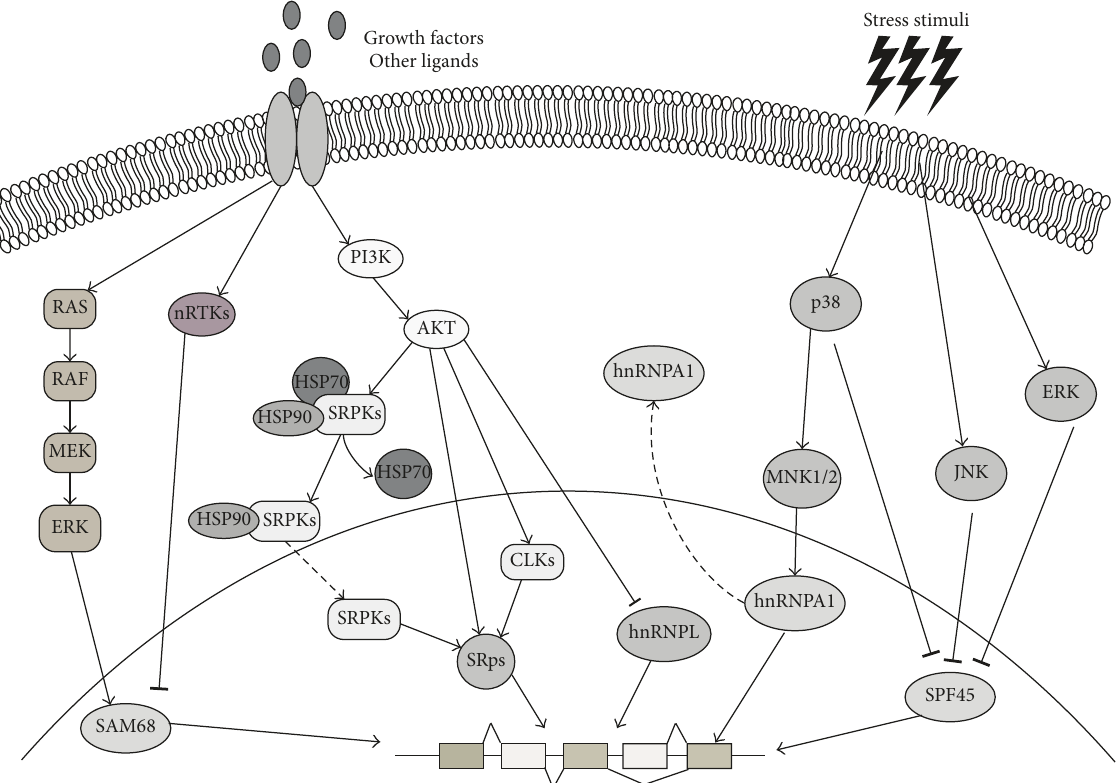
Figure 2: Signaling-activated kinases regulate splicing factor activity. Various extracellular cues, like growth factors or stress stimuli, activate different signal-transduction cascades impinging on protein kinases that in turn phosphorylate RBPs, thereby modulating their splicing activity. SAM68 splicing activity is inversely regulated by ERKs and nRTKs, which, respectively, activate and inhibit its splicing activity. The PI3K-AKT pathway regulates the activity of several SR proteins both directly or by phosphorylating and modulating the activity and localization of CLKs and SRPKs. Stress signal-activated kinases, like JNK or p38, can both modulate splicing factor localization, like for hnRNPA1, or activity, like for SPF45 (see text for